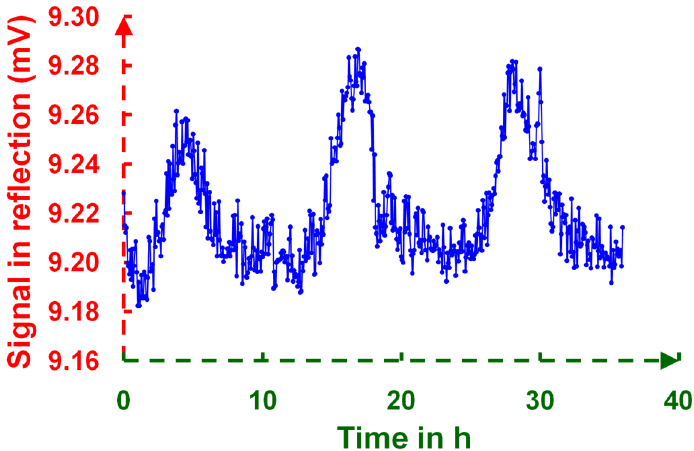
Figure 6. Laser fluctuations over a long time period (35